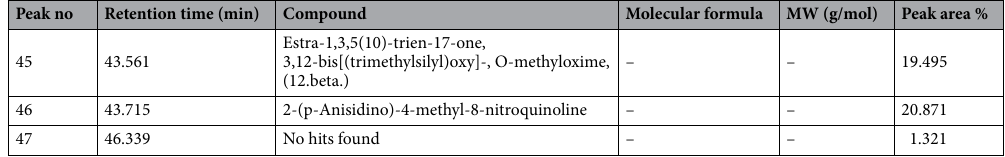
Table 2. Compounds available in ethyl acetate fraction of Caulerpa racemosa.